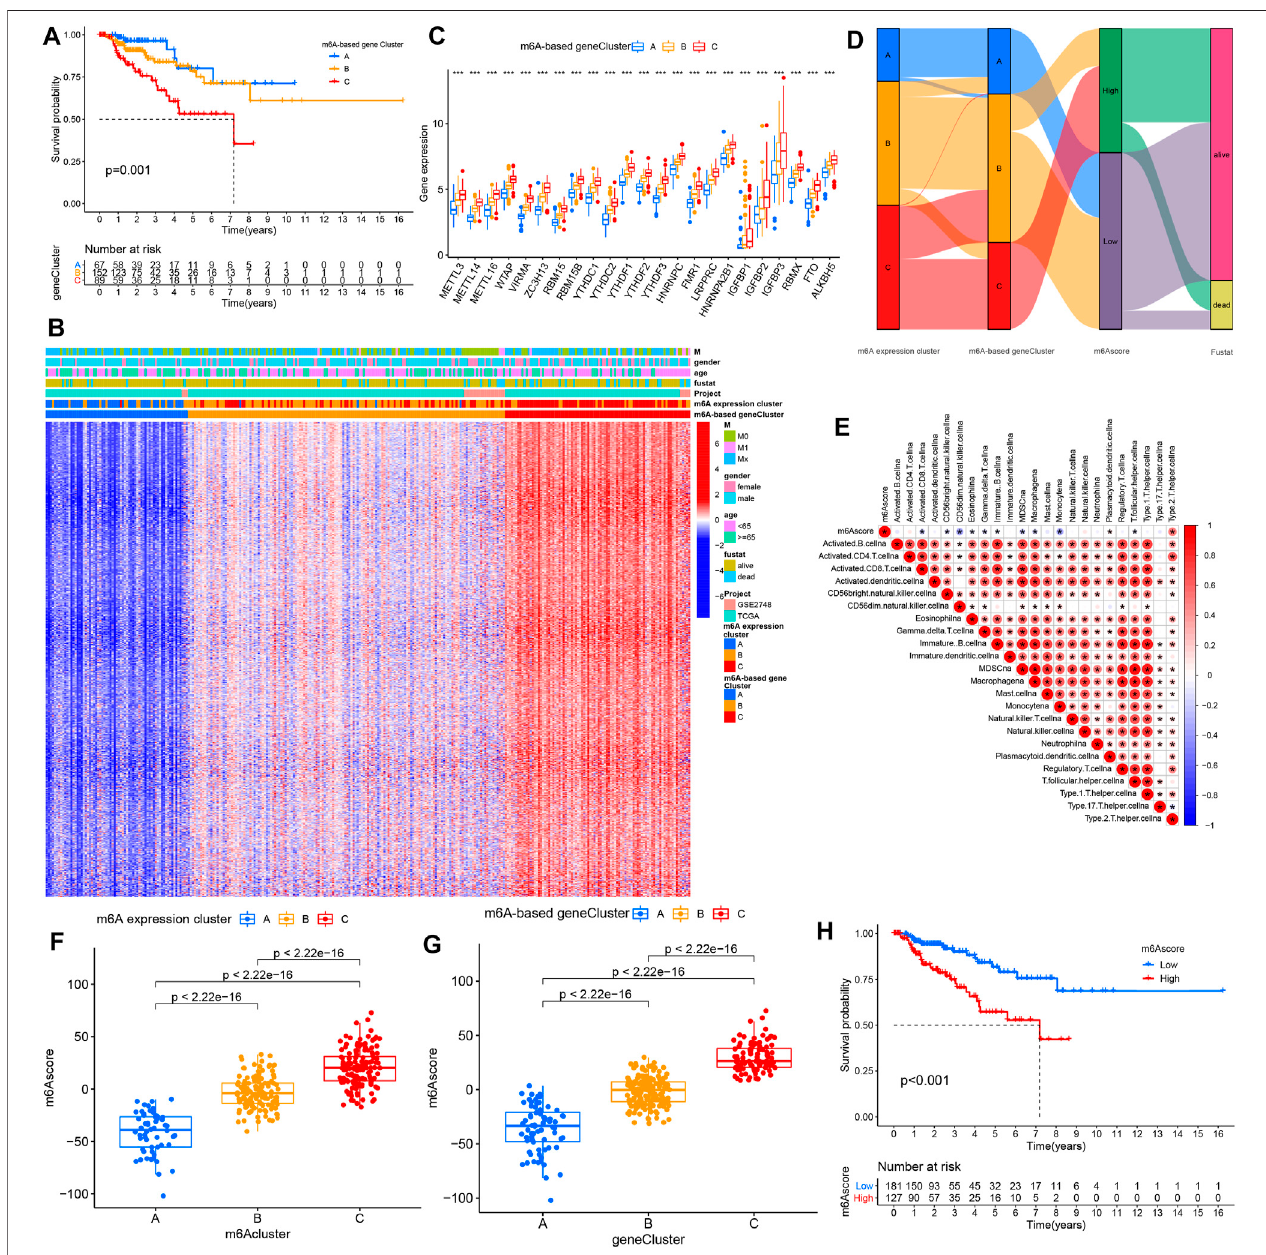
FIGURE 4 | Characteristics of diverse m 6 A-based gene expression clusters. (A) Kaplan – Meier survival analysis showed the OS for the three m 6 A-based gene expression clusters based on TCGA PRCC and GSE2748 data set with PRCC. (B) Unsupervised clustering of the intersected m 6 A phenotype-related genes in PRCC, whichclassi fi espatientsintoseveralclusters,termedm 6 A-basedgeneexpressionclusters.Them 6 Acluster,tumorMstage,survivalstatus,gender,andageareusedas annotations.Redmeanshighexpressionofm 6 Agenes,andbluerepresentslowexpression.TheMmeansmetastasis. (C) Expressionpatternof23m 6 Agenesfor the three m 6 A-based gene expression clusters. The histogram indicates the expression level of23m 6 Agenes between m 6 A-based geneclusterA, B, and C.The upper and lower ends of the boxes mean each the interquartile range (IQR) of values. The lines in the boxes represent median value. The asterisks represented the p value. (* p < .05; ** p < .01; *** p < .001). (D) Alluvial diagram displaying the differences in m 6 A expression clusters, m 6 A-based gene expression clusters, and m 6 Ascore. (E) Spearman analyses of the correlations between m 6 Ascore and biological characteristics in the PRCC cohort. (F , G) Differential analysis of m 6 A score values among (F) m 6 A expression clusters and (G) m 6 A-based gene expression clusters in TCGA PRCC and GSE2748 data sets. (H) K – M analyses for the OS of PRCC patients in high and low m 6 A score groups.